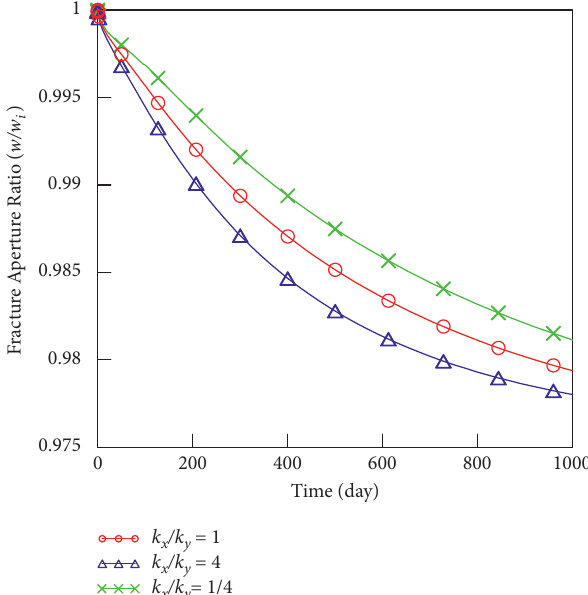
Figure 18: Fracture aperture history for fracture 1.